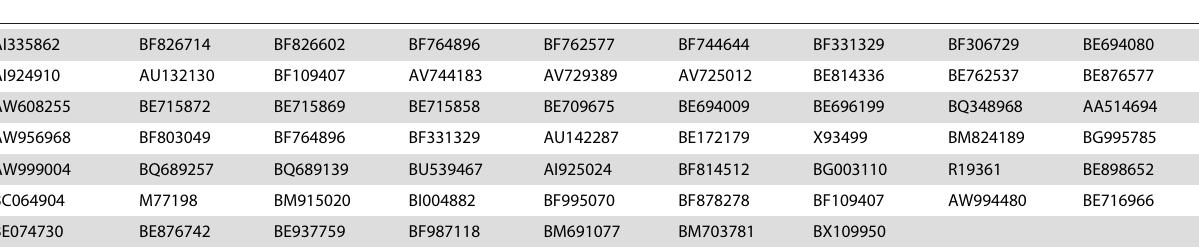
suggesting that NUMTs are stably expressed. Several ESTs had a reoccurrence with identical sequence, which enhances their fidelity. contained an mt-sequence showed one or several deleted regions that were set arbitrarily as 4 nucleotides (nt) or longer, such as in Table 1. Trimeric